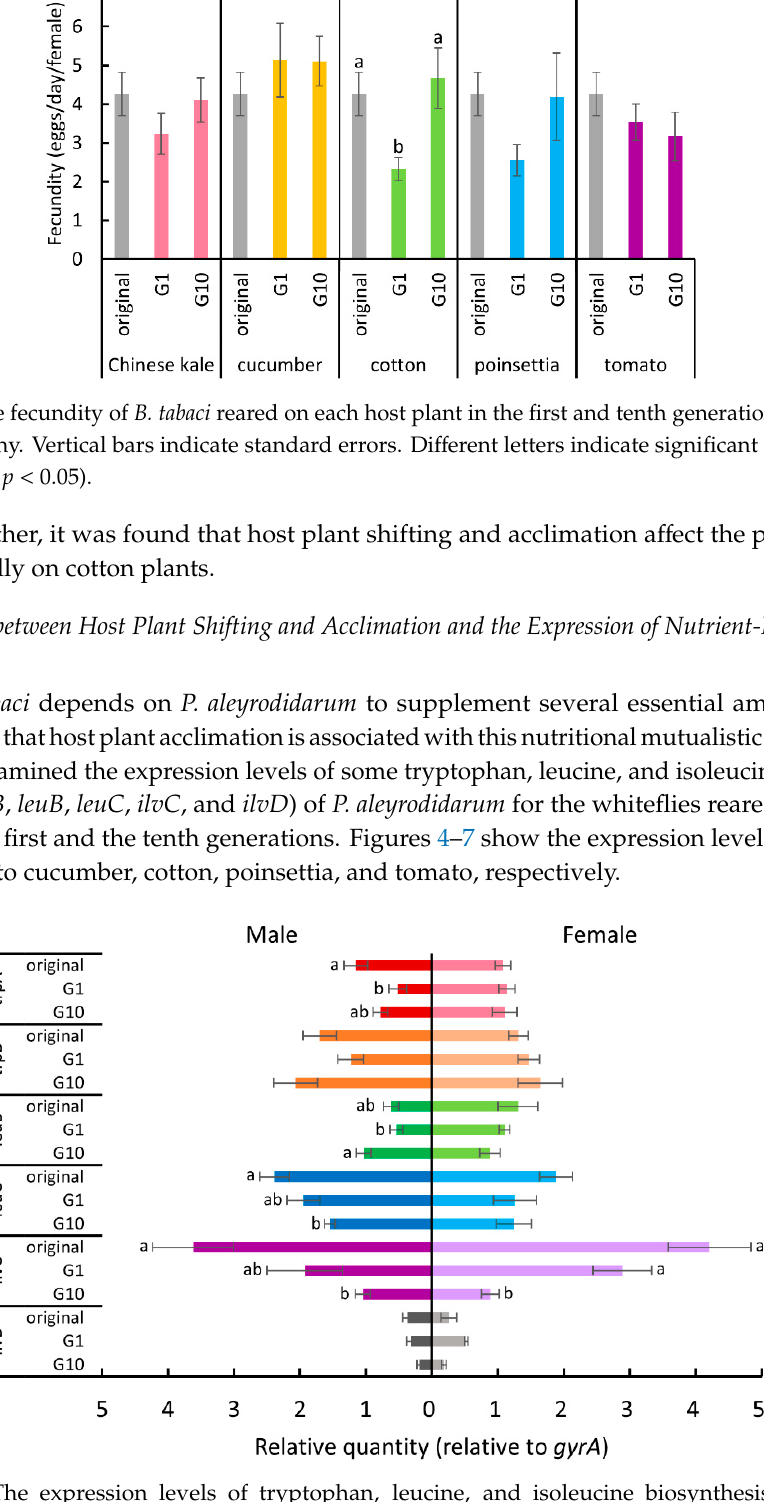
Figure 4. The expression levels of tryptophan, leucine, and isoleucine biosynthesis genes of P. aleyrodidarum in male and female B. tabaci reared on cucumber plants in the first and the tenth generations. Expression levels in the original colony are also shown. Horizontal bars indicate standard errors. Different letters indicate significant differences (Tukey test, p < 0.05).